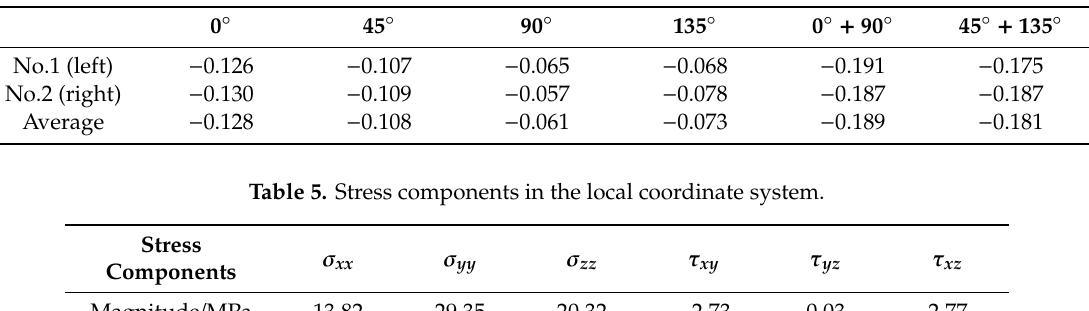
Table 4. Diametral displacements at di ff erent angles for the third borehole (Unit: mm).